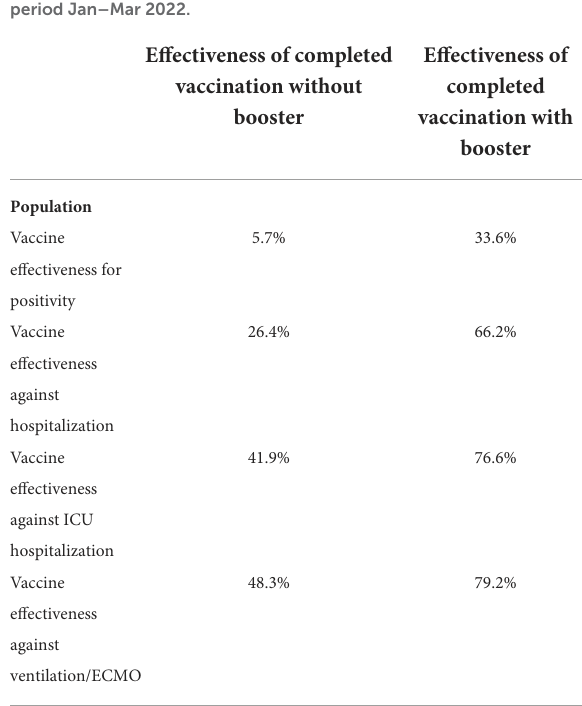
TABLE 2 Vaccine effectiveness in heart failure patients within the period Jan–Mar